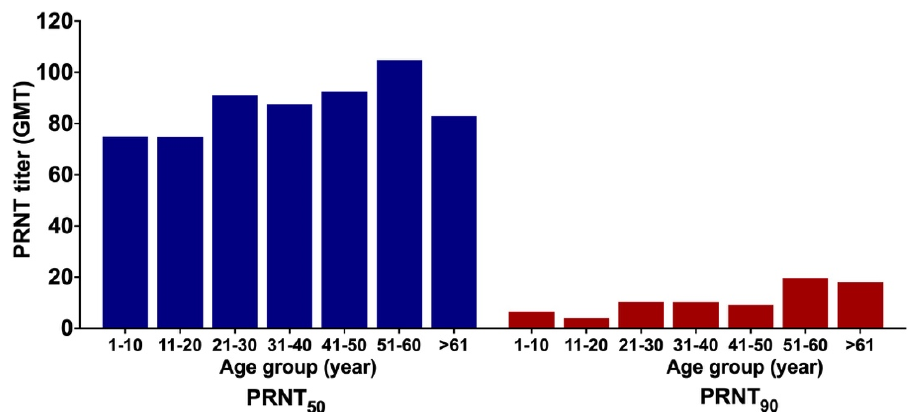
Figure 6. Geometric mean titers (GMTs) of ZIKV neutralizing antibody (NAb) at two thresholds (PRNT 50 and PRNT 90 ).